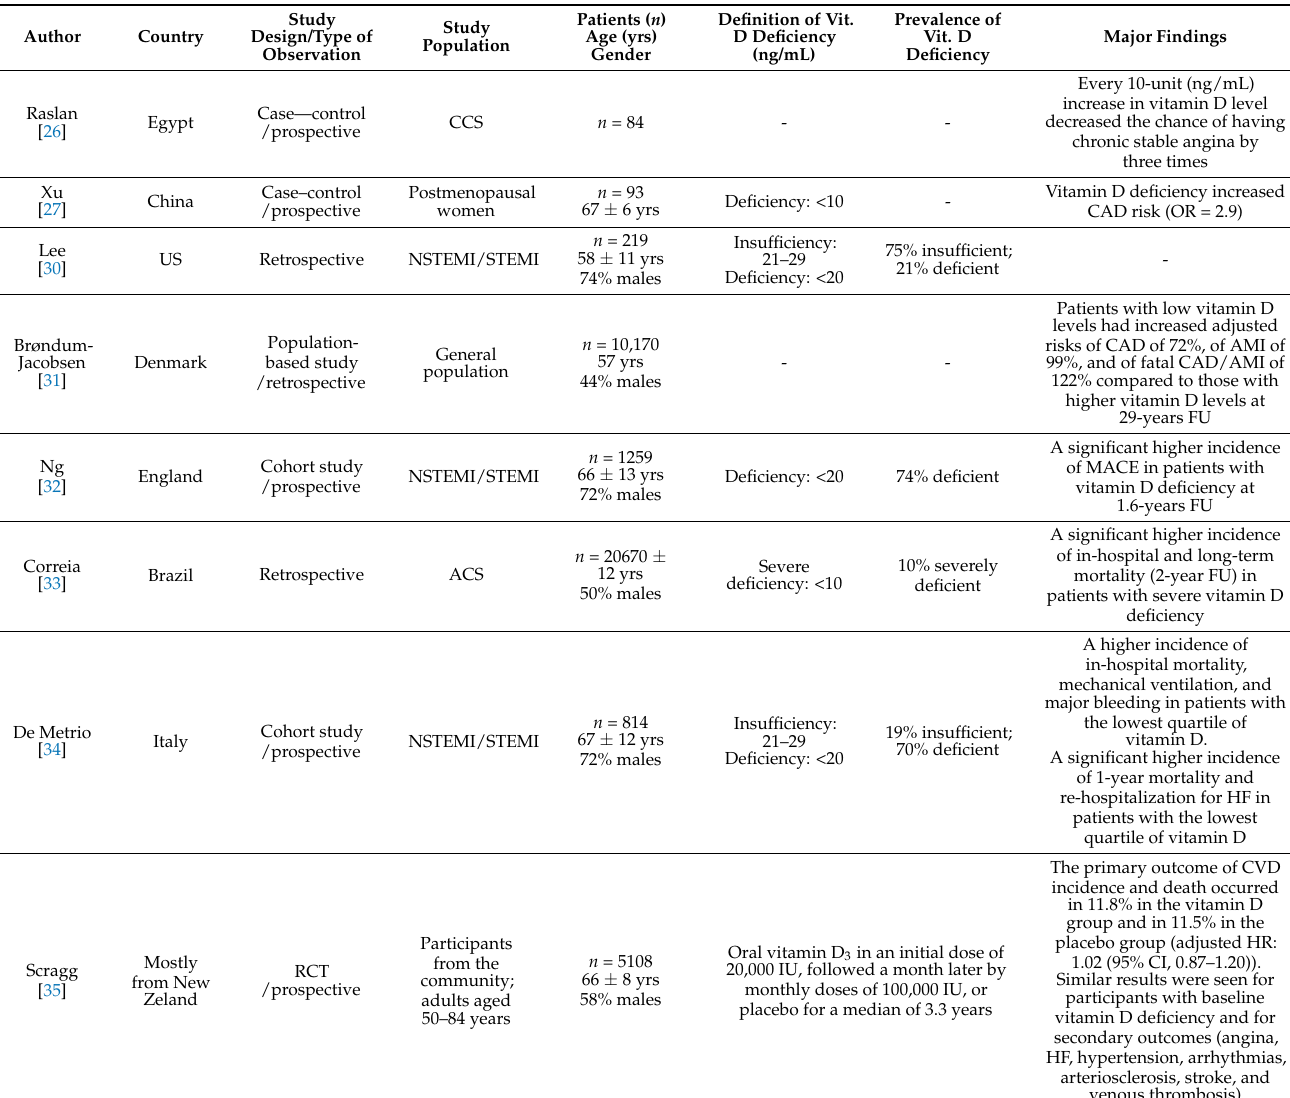
Table 1. Some of the major studies on the clinical relevance of vitamin D levels in patients with coronary artery